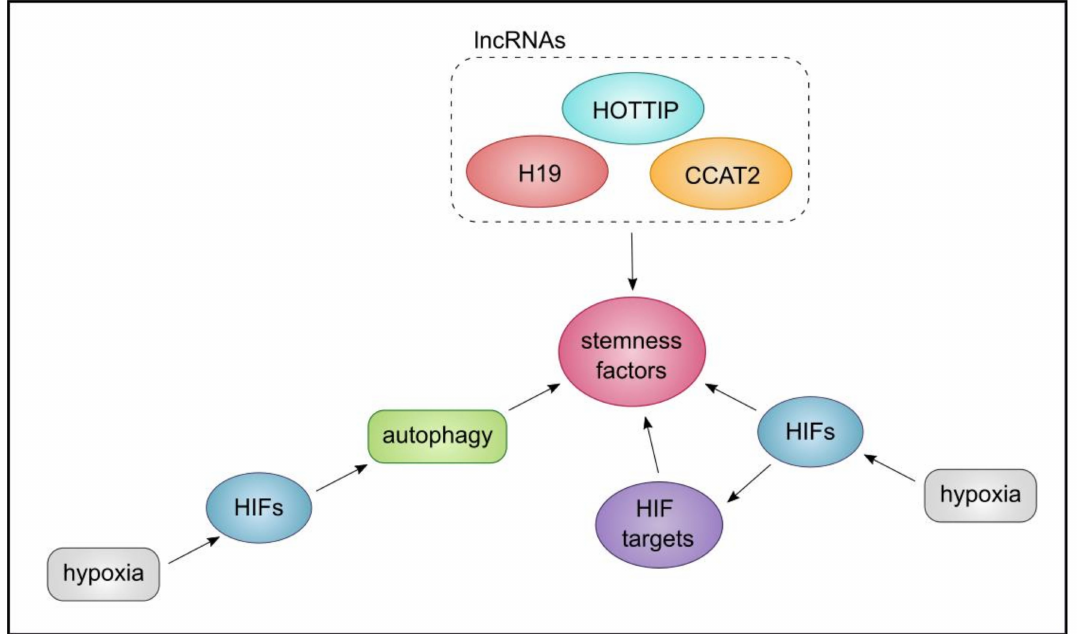
Figure 7. The contribution of autophagy and lncRNA to stemness factors in the tumour microenvironment (TME). In response to hypoxia, HIFs and their targets are triggered that can contribute to stemness factors. In turn, hypoxia-driven HIFs can trigger autophagy, as a means to survive the harsh conditions that and contribute to stemness factors. LncRNAs such as H19 , HOTTIP, and CCAT2, could directly contribute to stemness